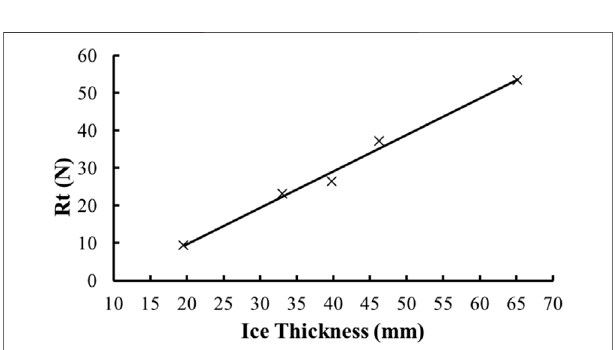
FIGURE 14 | In fl uence of brash ice thickness on ice